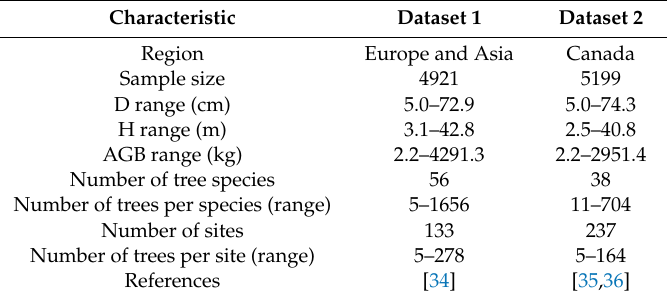
Table 1. The characteristics of analyzed datasets.